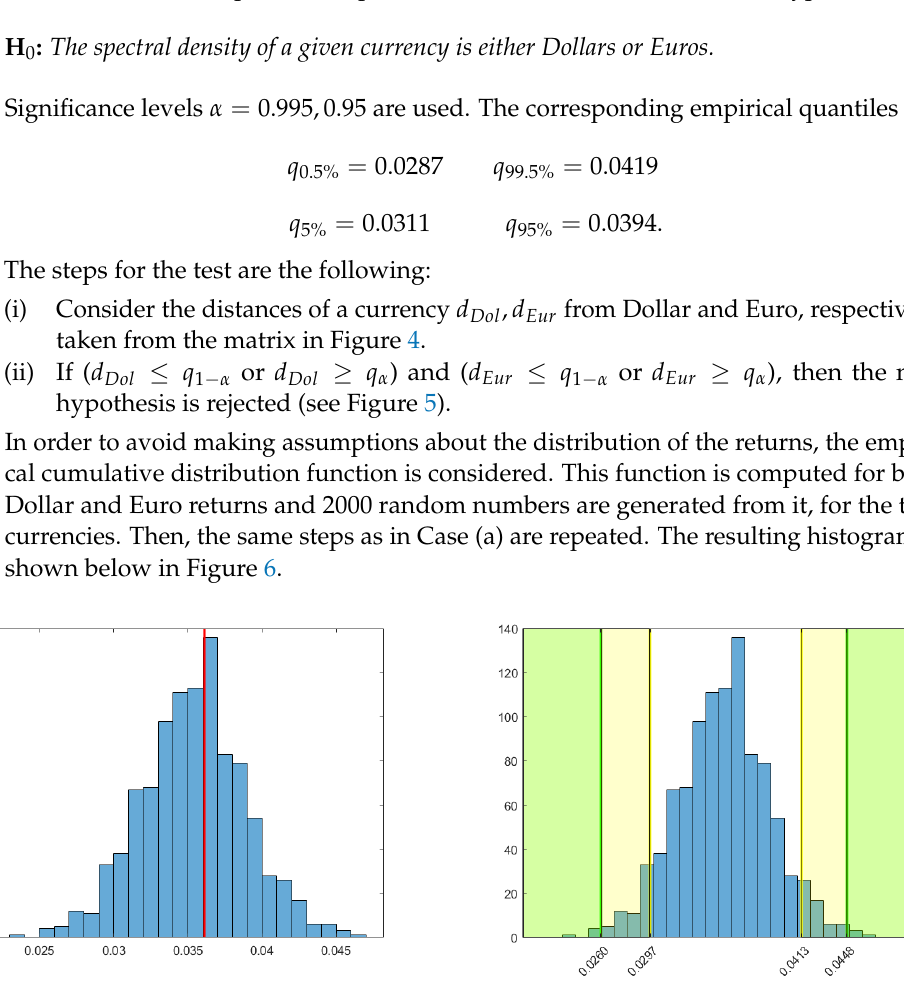
Figure 6. Case (b): probability distribution of the distance between Dollar and Euro ( left ) and rejection areas for α = 0.995 (green) and α = 0.95 (yellow) ( right ). The new quantiles are given in Formulas (8) and (9), and the new rejection areas